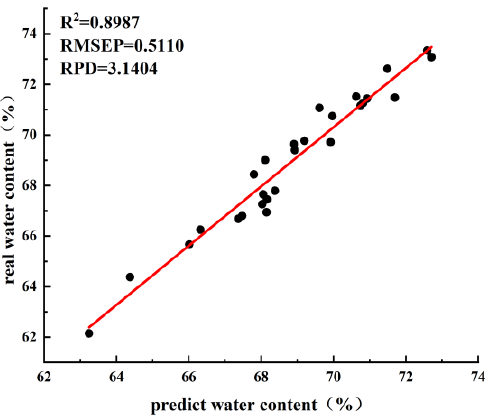
Figure 8. Correlation analysis of real and predicted values of water content of fresh leaf samples.